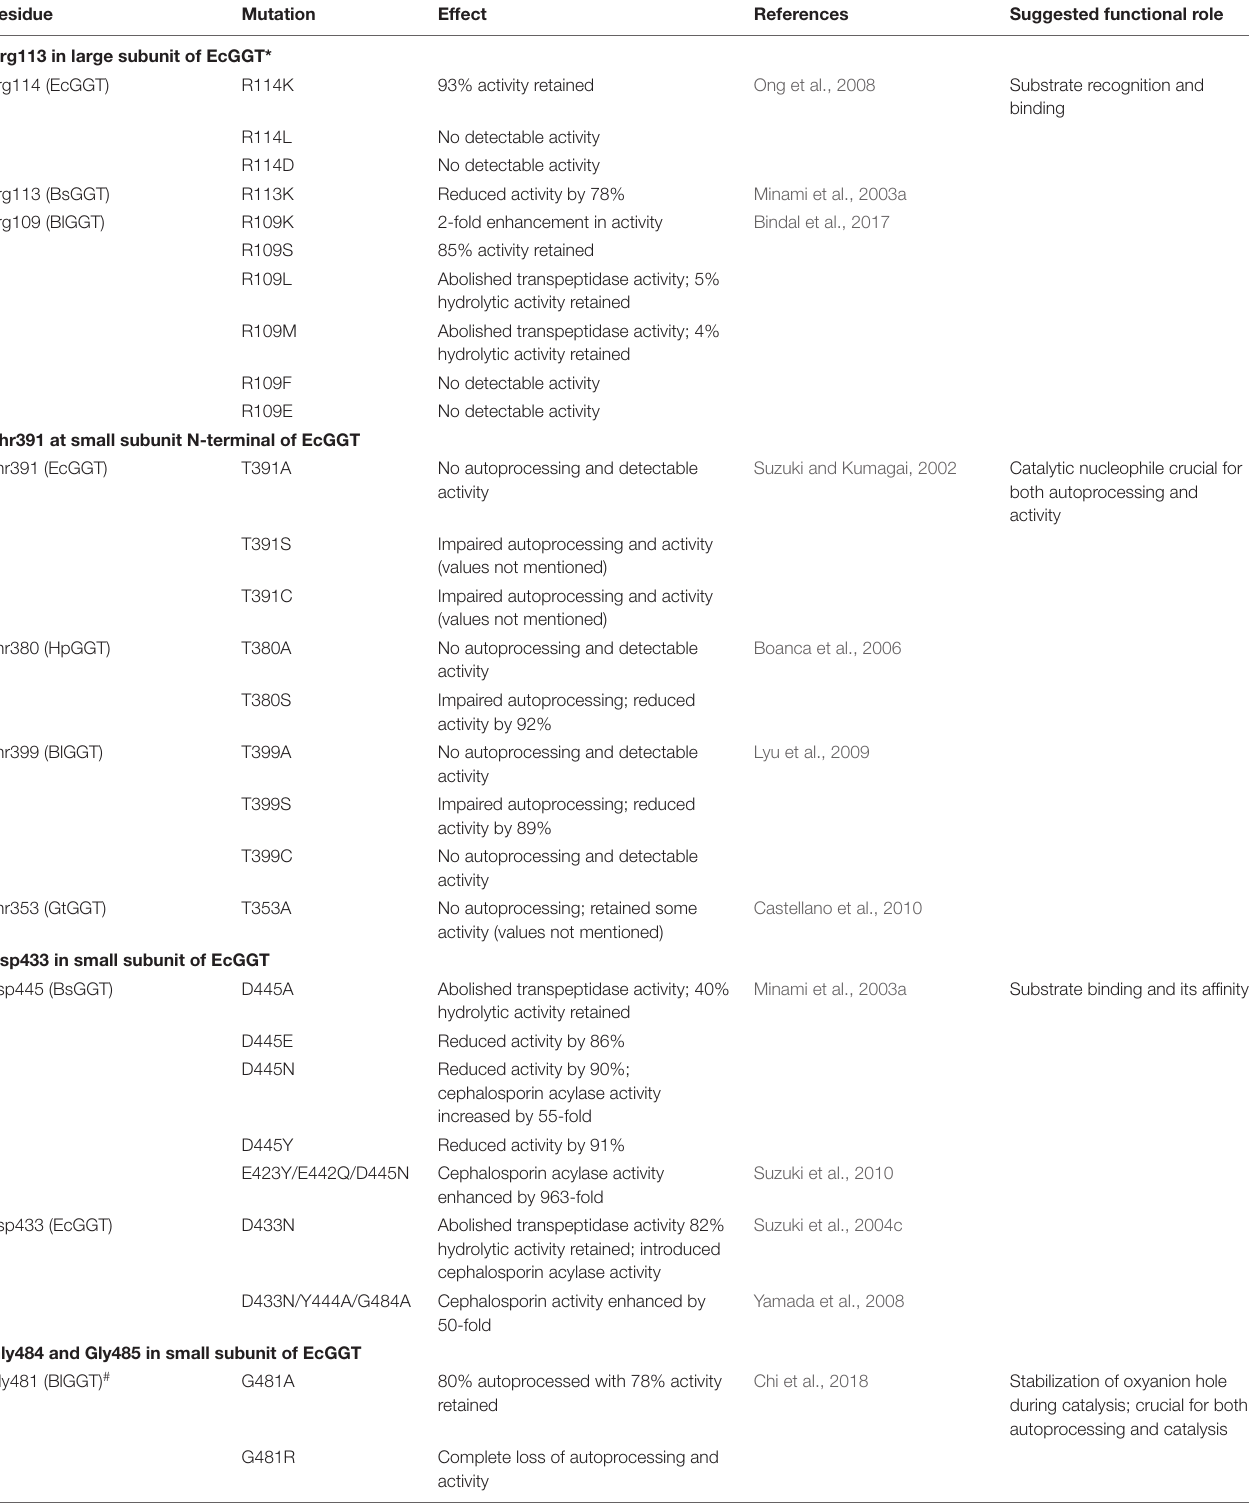
TABLE 3 | List of mutations performed in conserved and catalytically important residues of bacterial gamma-glutamyl transpeptidases (GGTs) and their effect on autoprocessing and activity. Residue